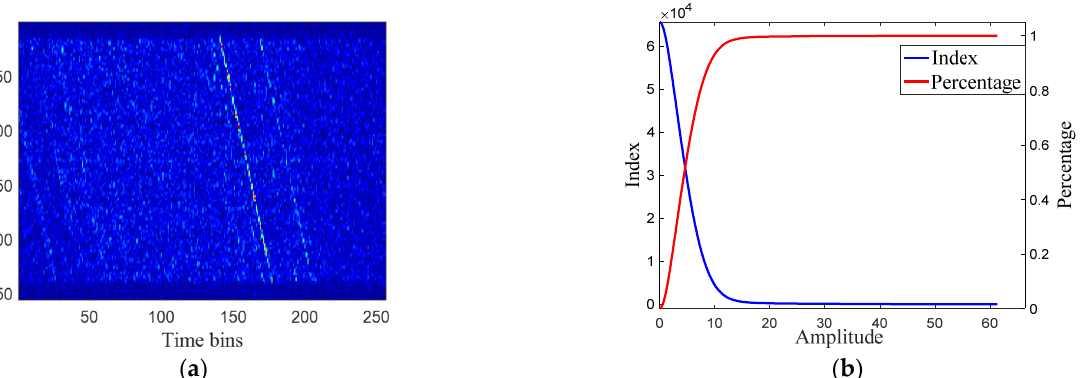
Figure 6. Structural analysis of TES in the TF domain: ( a ) TF spectrograms of TES; ( b ) amplitude analysis result corresponding to ( a ).